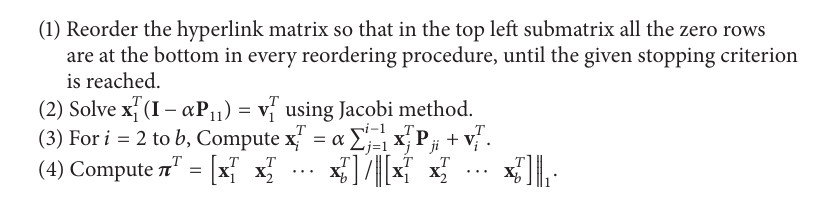
Algorithm 1: The reordered algorithm [13].